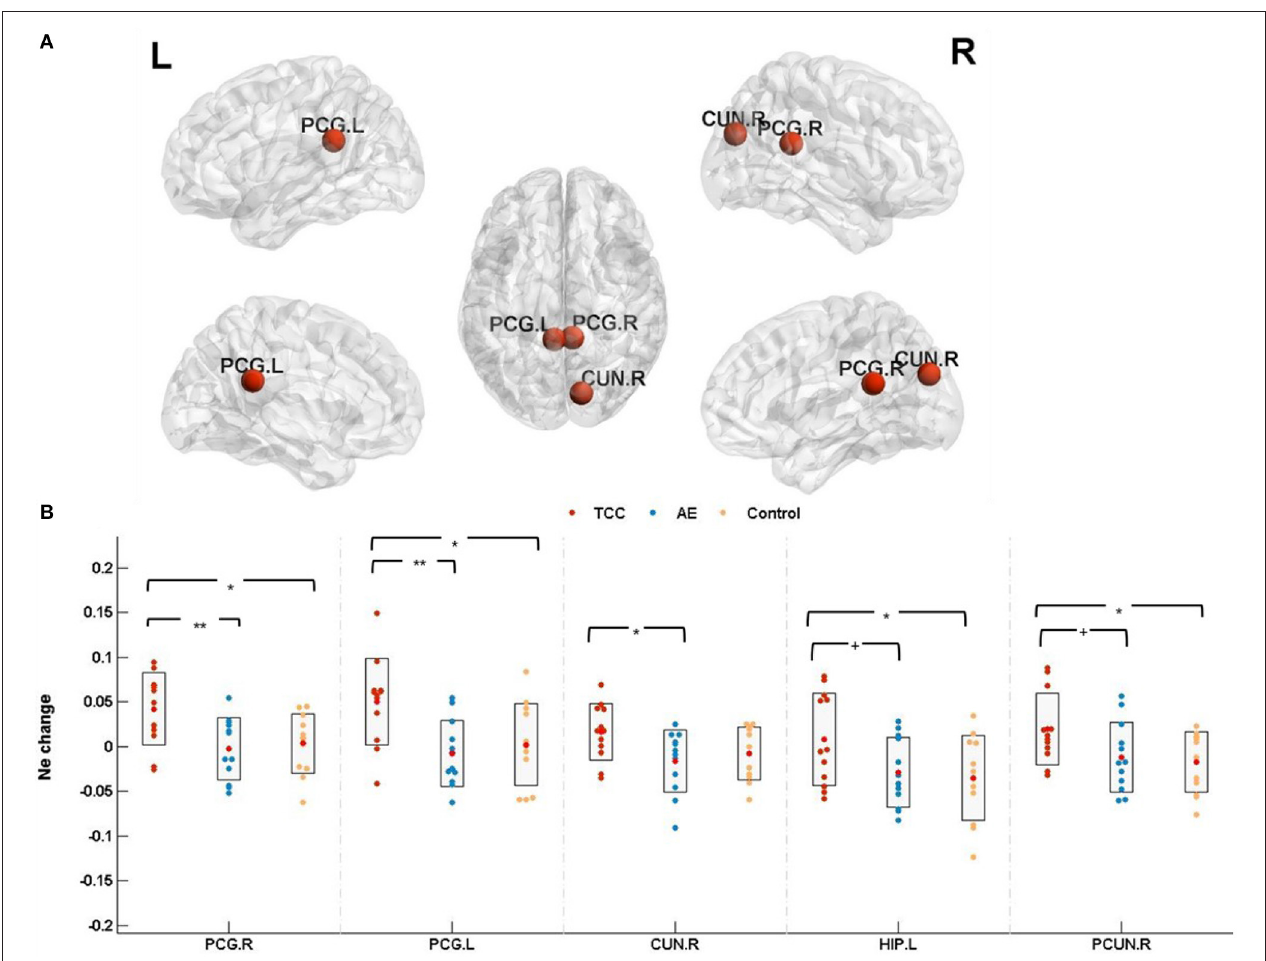
FIGURE 4 | Nodal efficiency results. (A) The results for nodal efficiency changes are presented on axial slices of the gray matter templates (MNI), Bonferroni-corrected. (B) The results of post-hoc statistical analysis of N e changes (post minus pre). + p < 0.06 (marginal significance); * p < 0.05; ** p < 0.01. PCG.R, right posterior cingulate; PCG.L, left posterior cingulate; CUN.R, right cuneus; HIP.L, left hippocampus; PCUN.R, right precuneus; N e , nodal